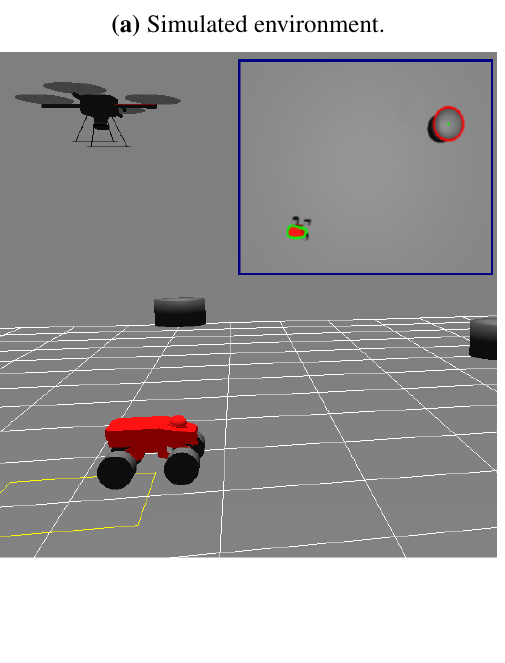
Figure 6. UAV and UGV in the proposed environments ( a ) Simulated environment. ( b ) Real environment. The blue squares in each figure represent the image acquired from the camera on board the aerial